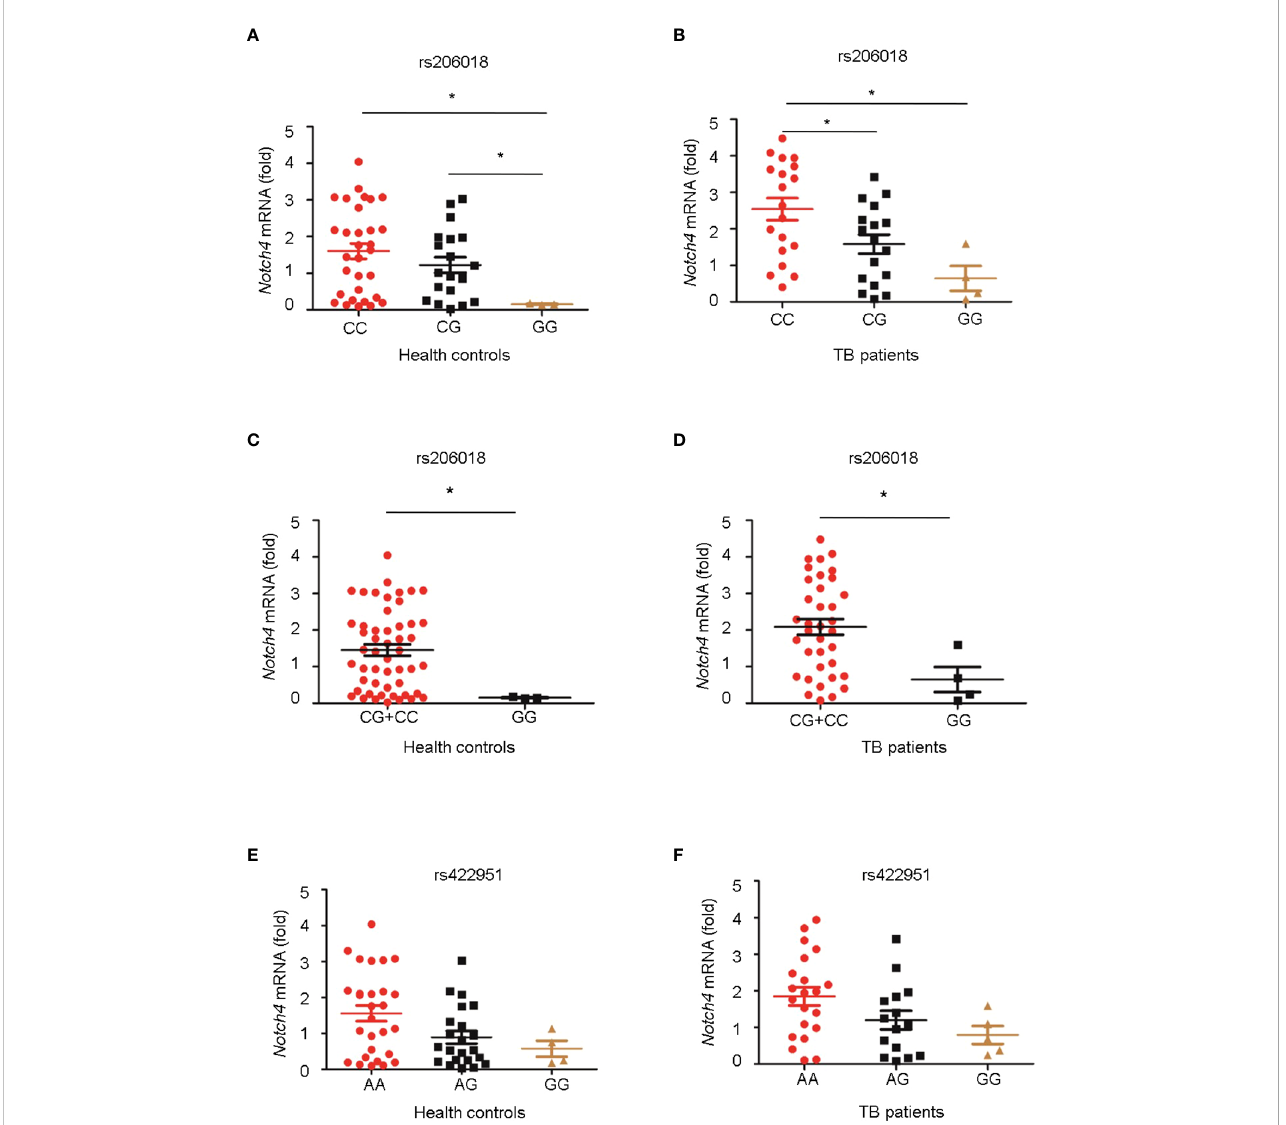
FIGURE 1 Association of Notch4 polymorphisms with its mRNA expression. Genomic DNA and mRNA were isolated from PBMC of healthy individuals and TB patients. Notch4 mRNA level was measured and normalized to gapdh gene. The genotypes of two Notch4 polymorphisms were examined for association with Notch4 mRNA expression. (A, B) Association between Notch4 SNP rs206018 and Notch4 mRNA level in healthy controls (A) and in TB patients (B) . (C, D) Notch4 SNP rs206018 affects Notch4 mRNA expression in a recessive model in health controls (C) and in TB patients (D) . (E, F) Association between Notch4 SNP rs422957 and Notch4 mRNA level in healthy controls (E) and in TB patients (F) . Difference between two groups were analyzed by Mann-Whitney U test due to the variance was not homogeneous, * p <